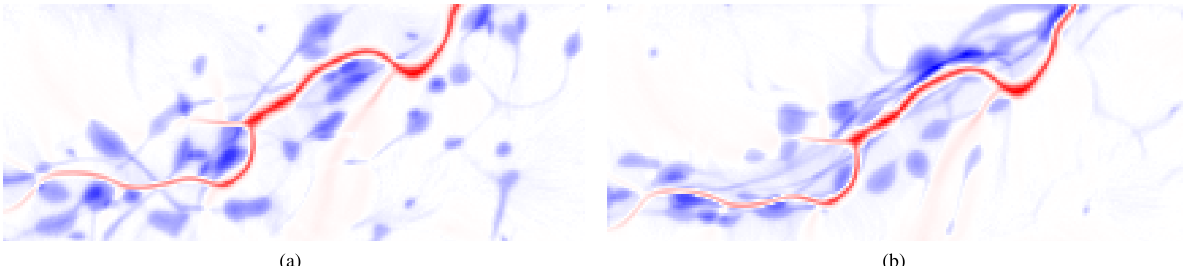
Figure 8: Detail of the difference of (a) the mean of digitally sculpted models and (b) the mean of tangibly sculpted models from the reference